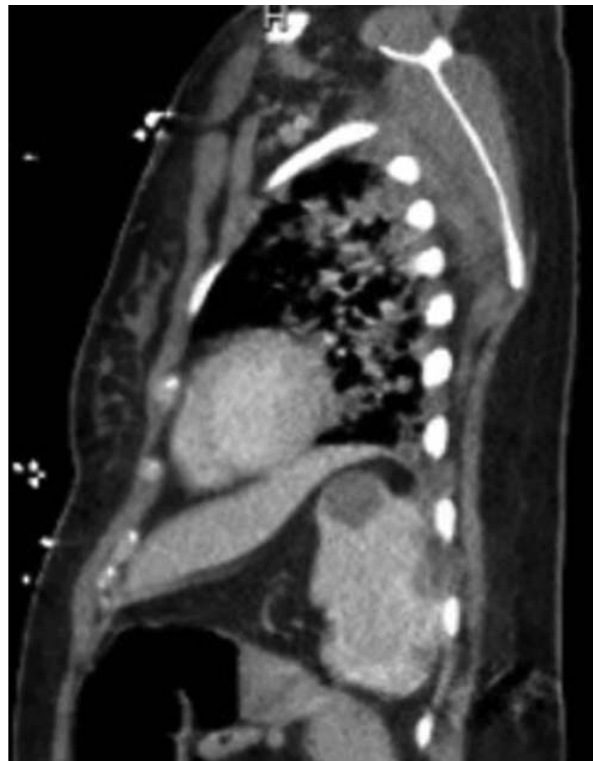
Fig. 2 CT abdomen (sagittal view) with multiple infarcts in the spleen. CT, computed